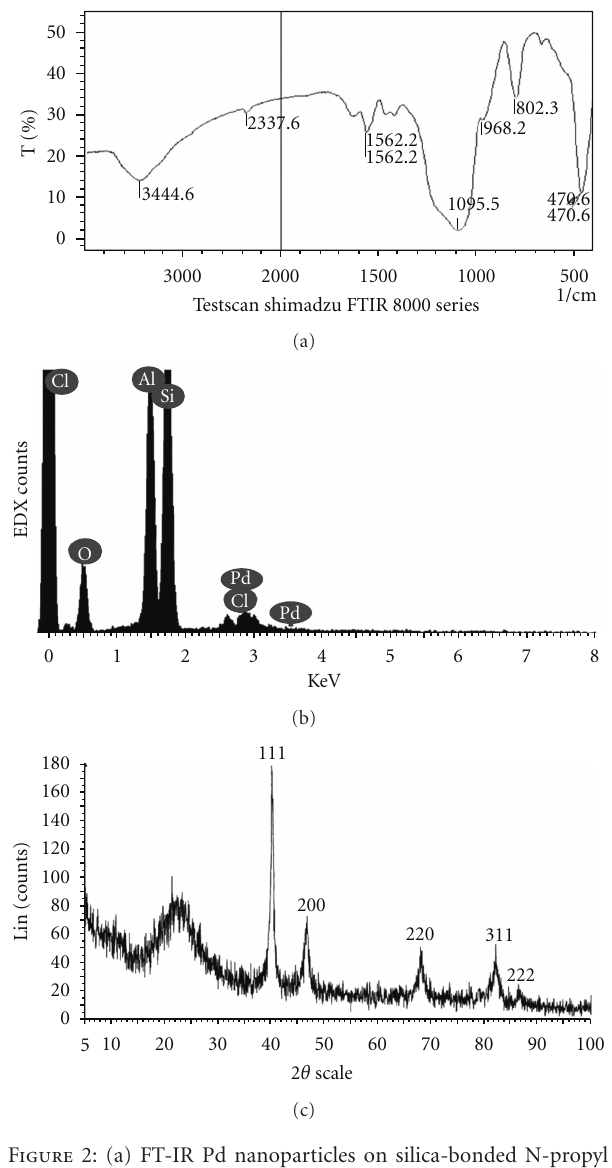
Figure 2: (a) FT-IR Pd nanoparticles on silica-bonded N-propyl morpholine, (b) energy dispersive X-ray spectra (EDX) of PdNP- SBNPM, (c) XRD of PNP-SBNPM.